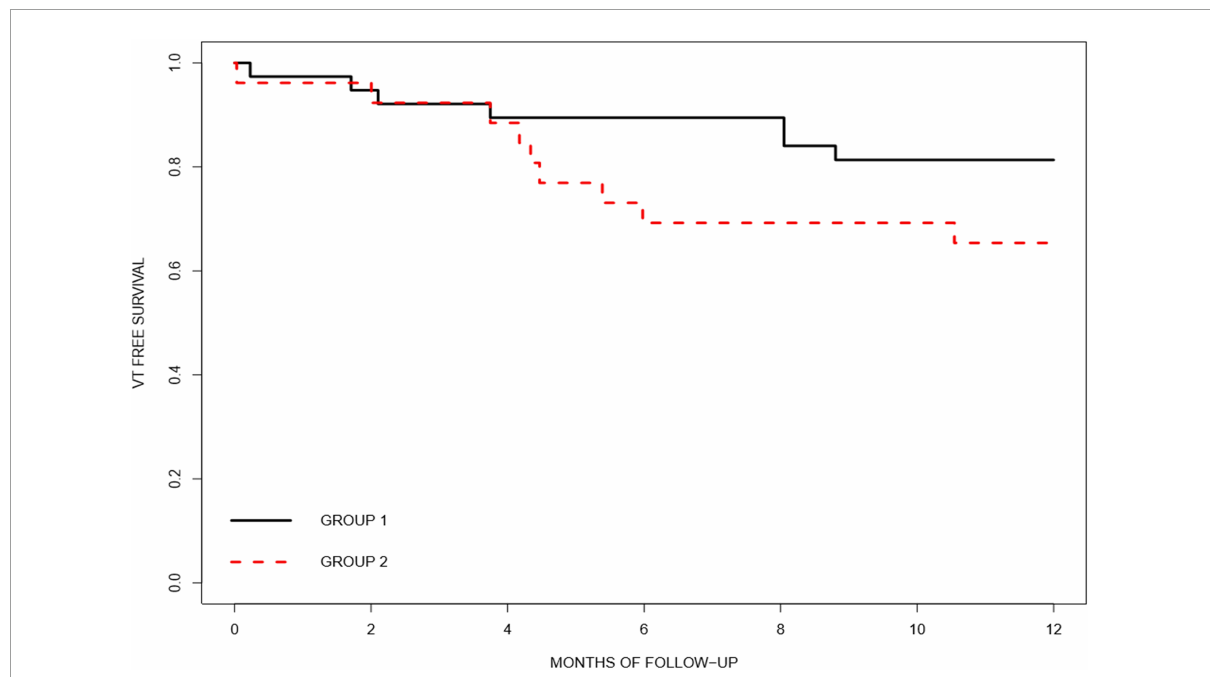
FIGURE3 The Kaplan–Meier curve showing ventricular tachycardia-free survival after ablation by group (group 1, extensive HD mapping, black; group 2, scar dechanneling,